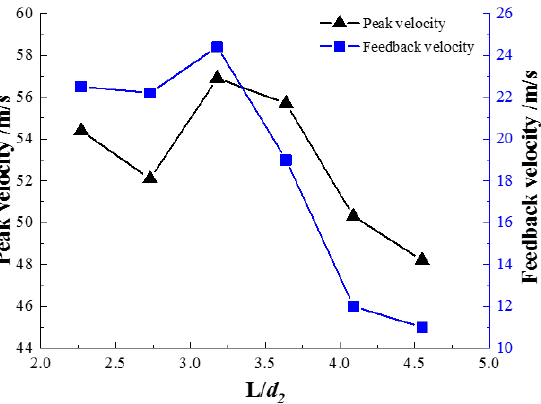
Figure 16. Curves of peak velocity and feedback velocity with cavity length.